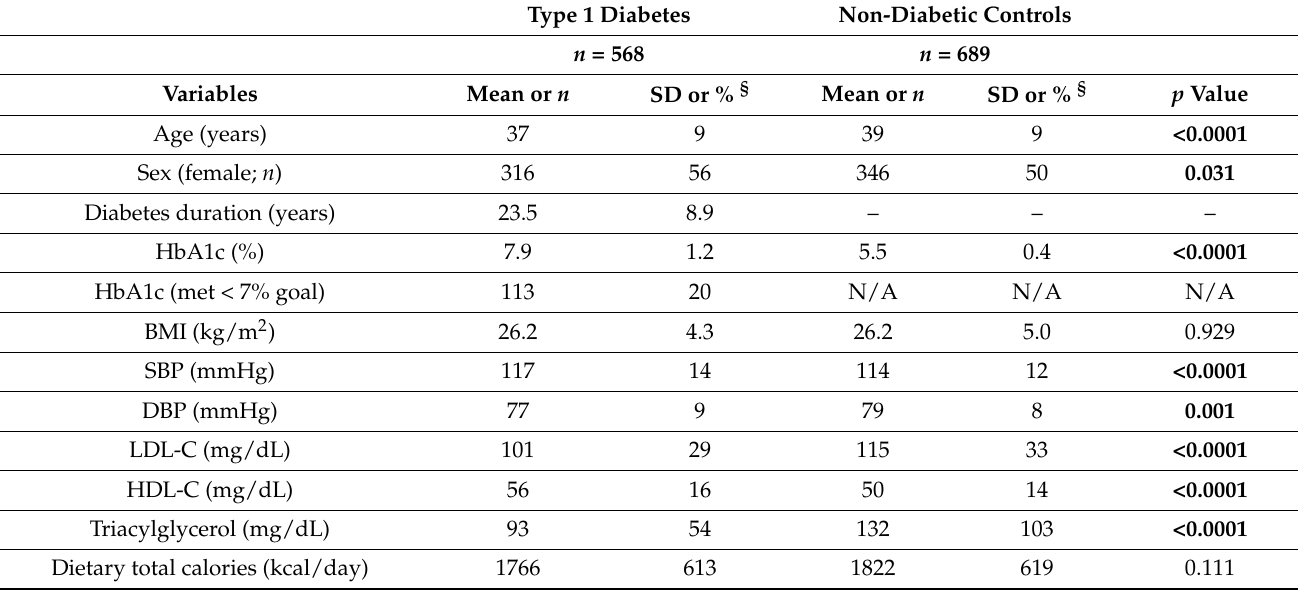
Table 1. Baseline characteristics of